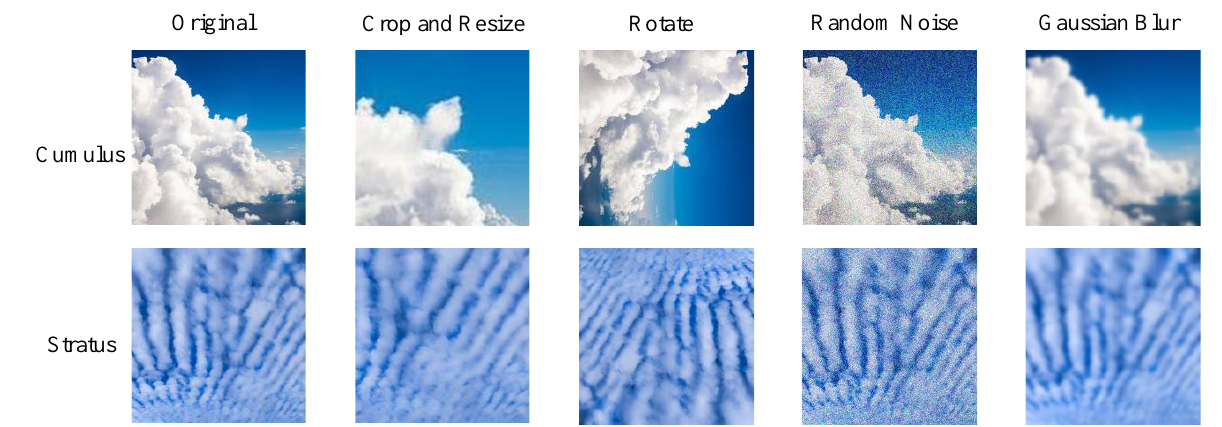
Figure 3. Examples of data augmentation.